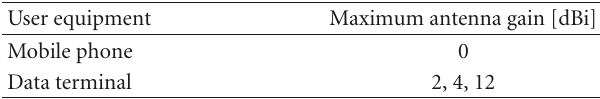
Table 1: Antenna gains used in the simulation